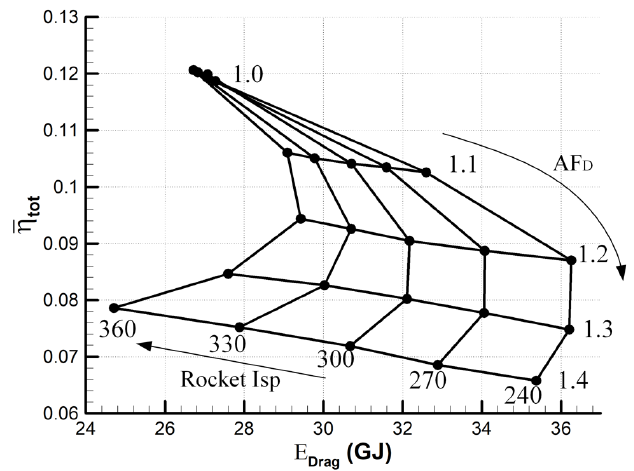
Figure 16. Effect of rocket Isp and vehicle drag on 𝜂̅ 𝒕𝒐𝒕 and 𝐸 𝐷𝑟𝑎𝑔 . Figure 16. E ff ect of rocket Isp and vehicle drag on η